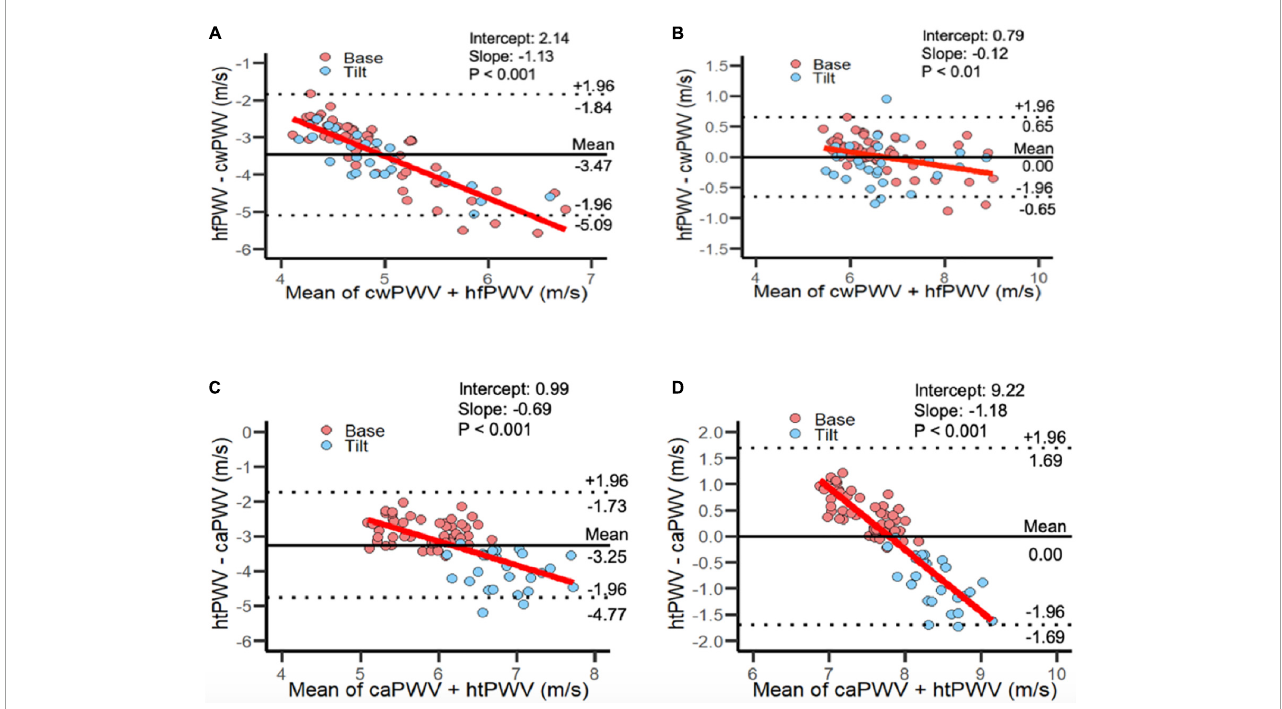
FIGURE3 Limits of Agreement plots for panel (A) uncorrected and (B) corrected heart-finger pulse-wave velocity vs. carotid-wrist pulse-wave velocity; combined Base and Tilt. [81 data points per plot: (27 subjects × 3 time points)]. Limits of Agreement plots for panel (C) uncorrected and (D) corrected heart-toe pulse-wave velocity and carotid-ankle pulse-wave velocity; combined Base and Tilt: [81 data points per plot: (27 subjects × 3 time points)]. caPWV, carotid-ankle pulse-wave velocity; cwPWV, carotid-wrist pulse-wave velocity; hfPWV, heart-finger pulse-wave velocity; htPWV, heart-toe pulse-wave